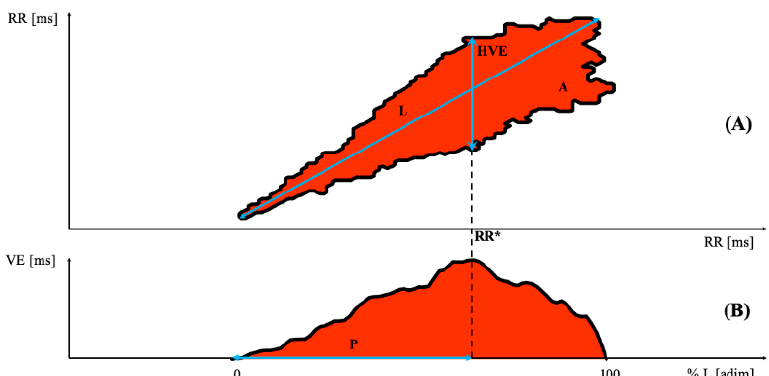
Figure 1. ( A ) Example of a 2D scatter plot RR vs. RR presenting the visual representation of the following extracted parameters: length (L [ms]), highest variability extension (HVE [ms])—related to the RR value showing the maximum width (RR *)—and area (A [(ms) 2 ]). ( B ) Curve which represents the measure of VE at different RR intervals; the percentage of the length which corresponds to the maximum amplitude (HVE) of the plot is P ([%]).